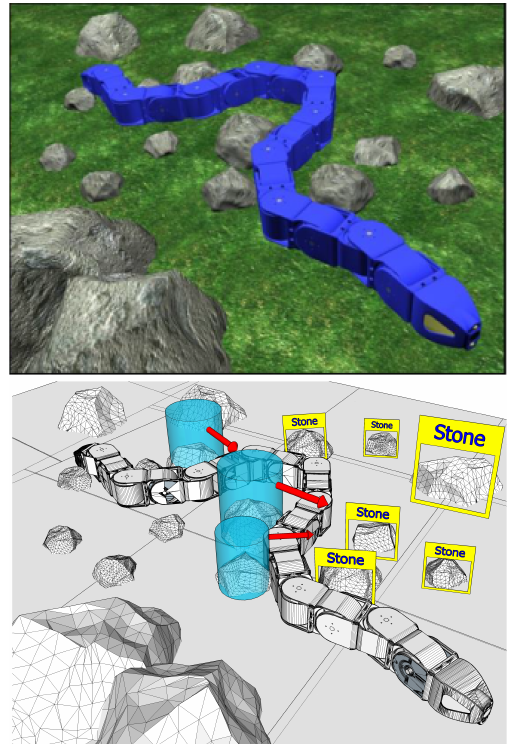
Figure 1. The underlying idea of snake robot perception-driven obstacle-aided locomotion: a snake robot perceives and understands its environment in order to utilise it optimally for